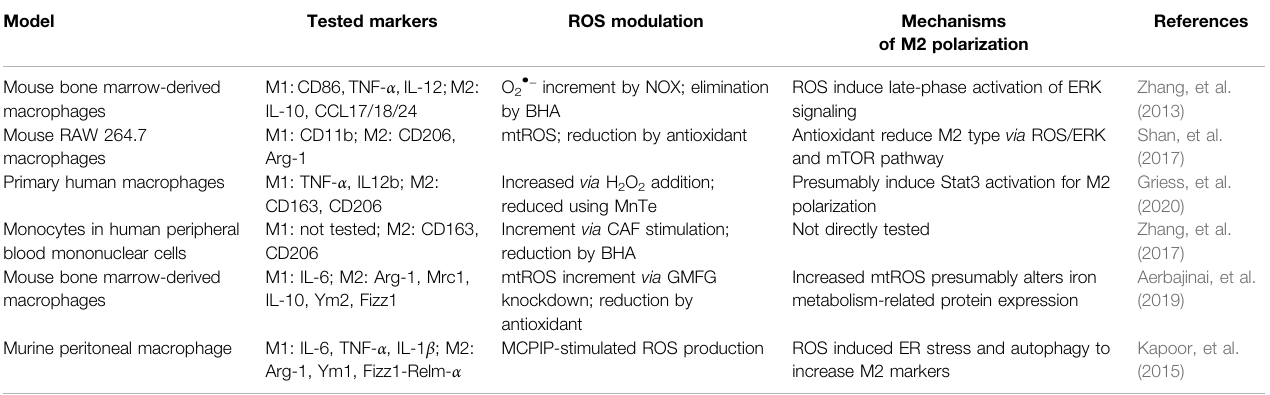
TABLE 1 | Representative studies reporting the ROS-promoted M2 polarization of macrophages.